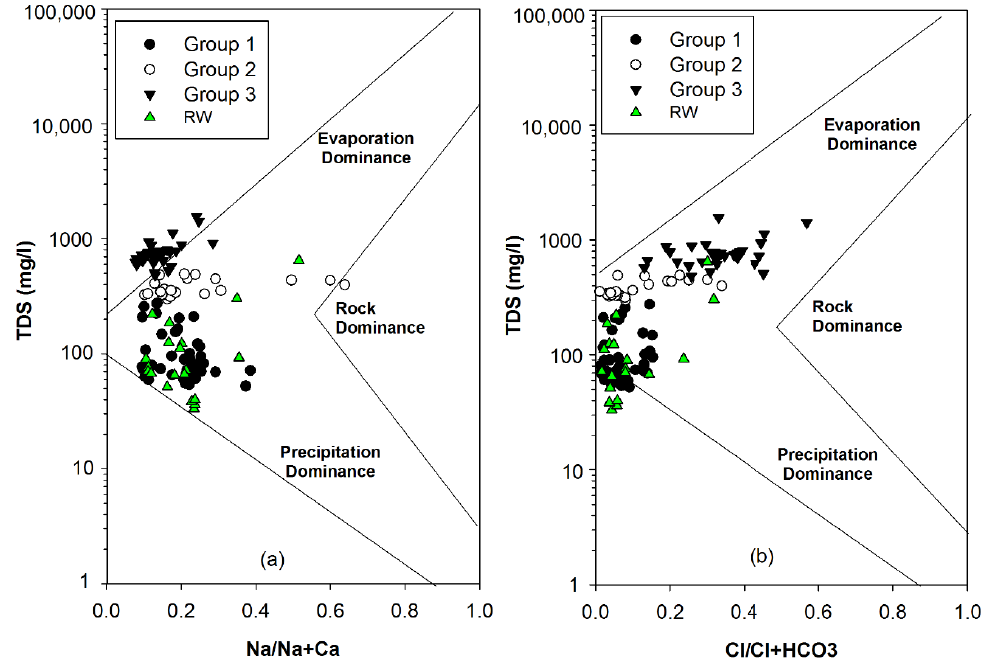
Figure 4. Variation in the Na/(Na + Ca) and Cl/(Cl + HCO 3 ) ratios ( w / w ) as a function of the total dissolved solids (TDS) in the water resources (adapted from [41]).